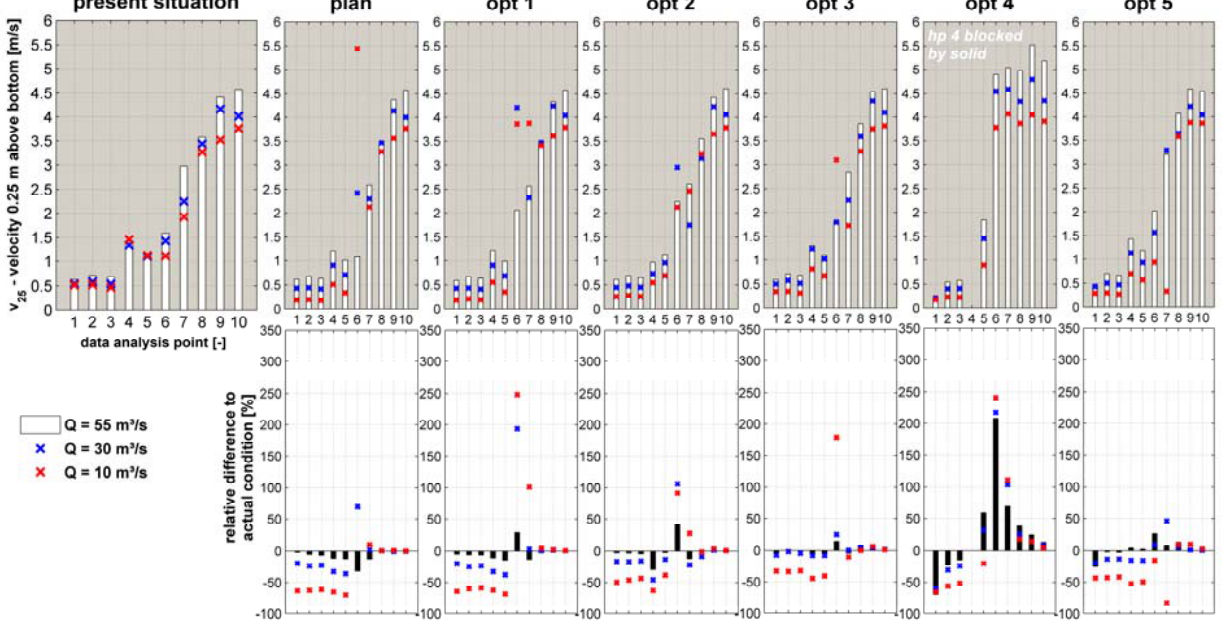
Fig. 5. Results from hydrodynamic numerical modelling for the discharges Q = 10m 3 s − 1 , Q = 30m 3 s − 1 and Q = 55m 3 s − 1 – top row: near-bottom velocities v 25 at the data analysis points 1–10 (Fig. 3) for the present situation and the design layouts (Fig. 4); bottom row: (cid:0) v (cid:1) · 100 25 , designlayout − v 25 , actualcondition relative differences of v 25 , each percental with relation to the present v 25 , actualcondition